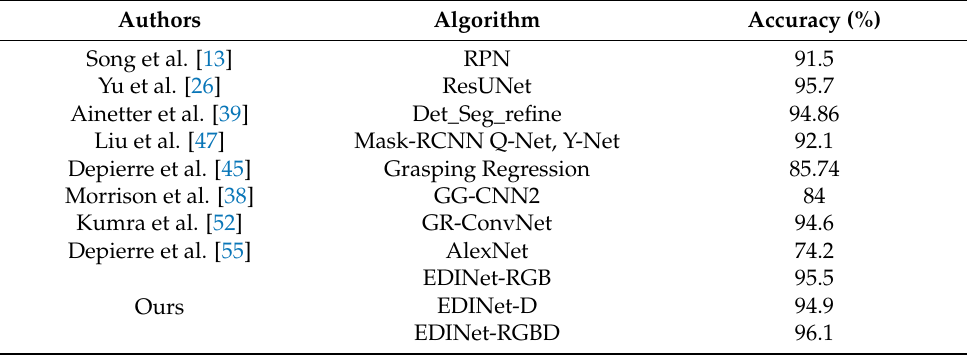
Table 4. Evaluation results on the Jacquard grasp